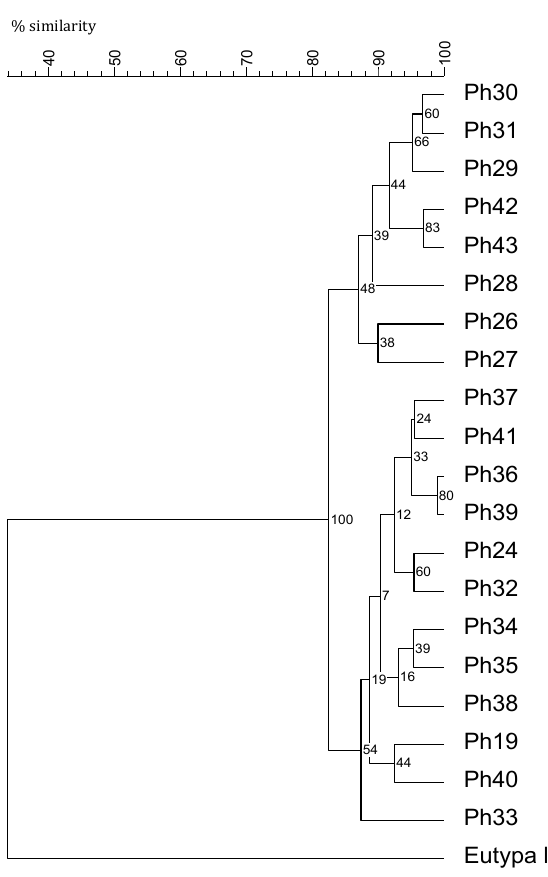
Figure 4. UPGMA cluster analysis based on Dice coefficient of ISSR fingerprints from a collection of isolates of Phaeo- moniella chlamydospora with the primers (AG) 8 Yt, (caG) 5 , HVH(TG) 7 and MR. The numbers at the nodes represent bootstrap support values (2,000 replicates). An Eutypa lata isolate was used as outgroup.